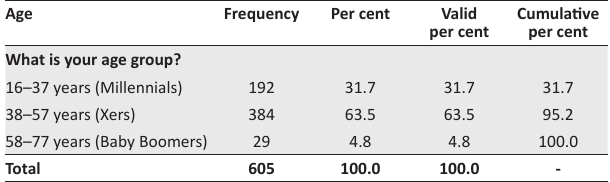
TABLE 3: Participants’ generation cohort.